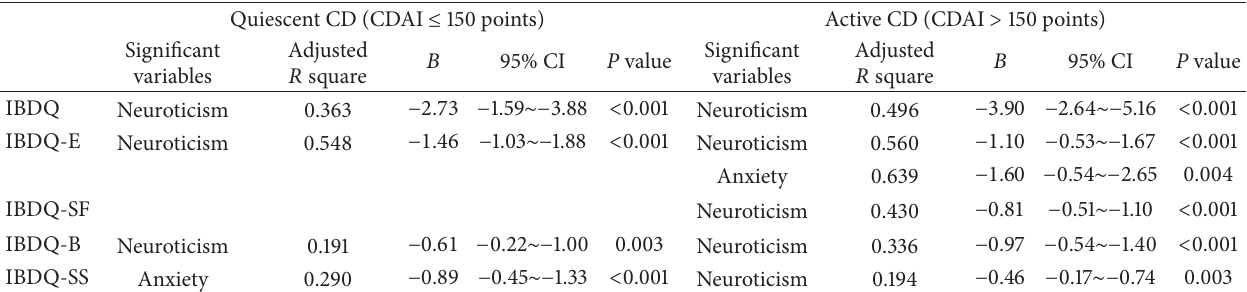
Table 6: Multiple linear regression analysis between different psychological variables and Inflammatory Bowel Disease Questionnaire and its subscales in patients with Crohn’s